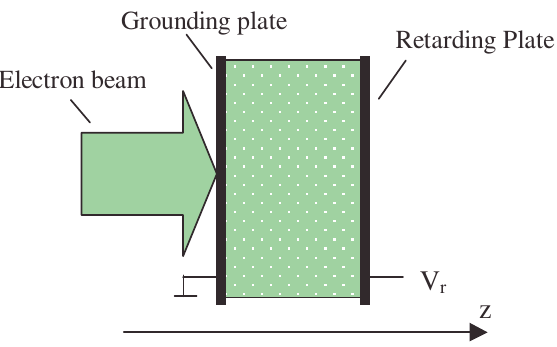
FIG. 2. (Color) Measured energy spectrum for a 5 keV beam, with a tail at the high-energy